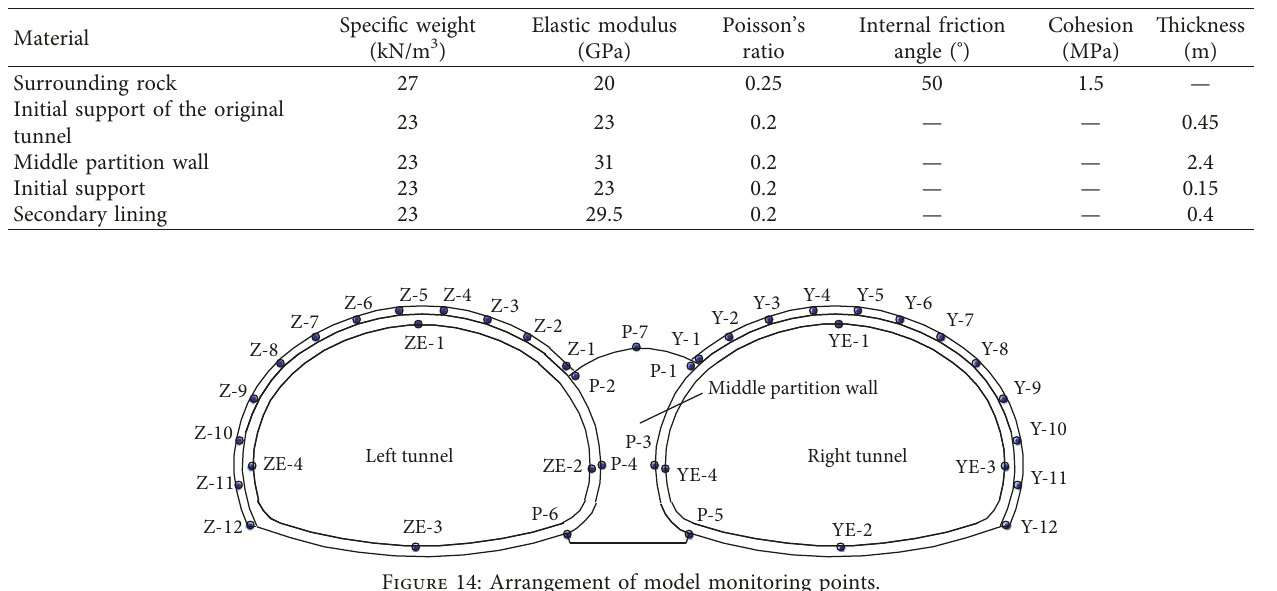
Table 3: Parameters of the surrounding rock and support